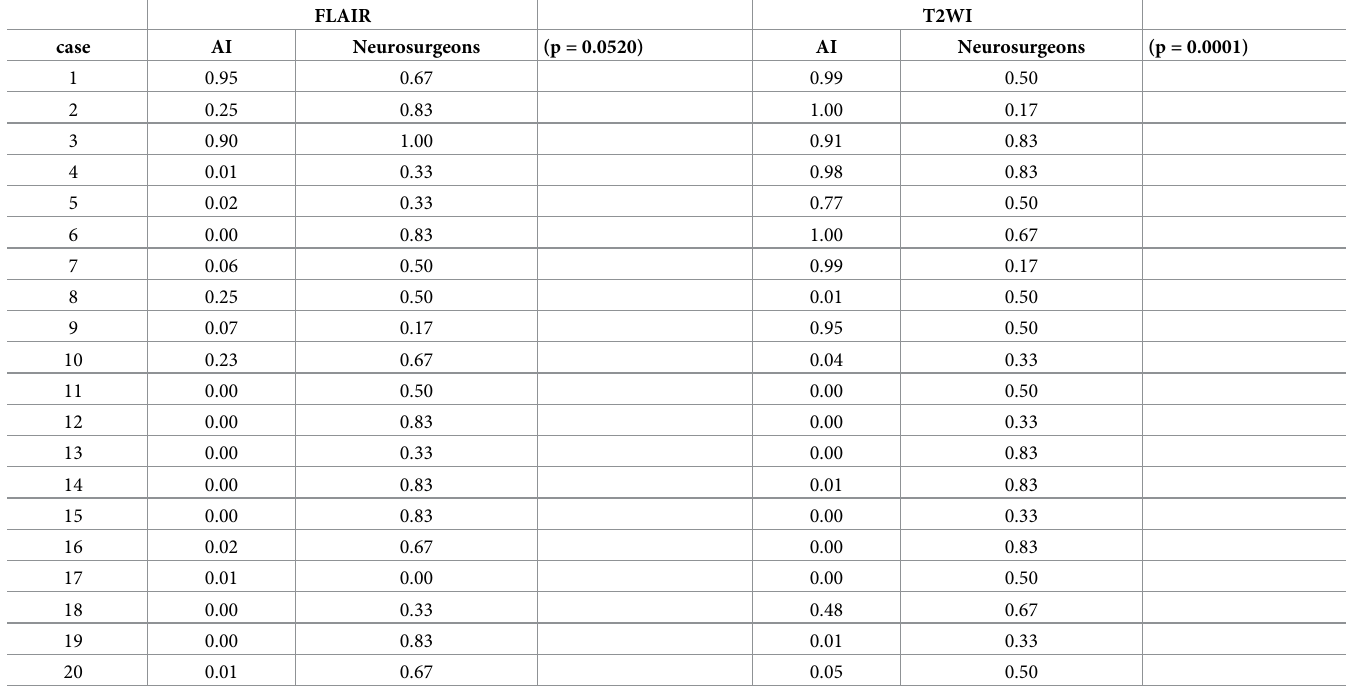
Table 4. Diagnostic accuracy of artificial intelligence &